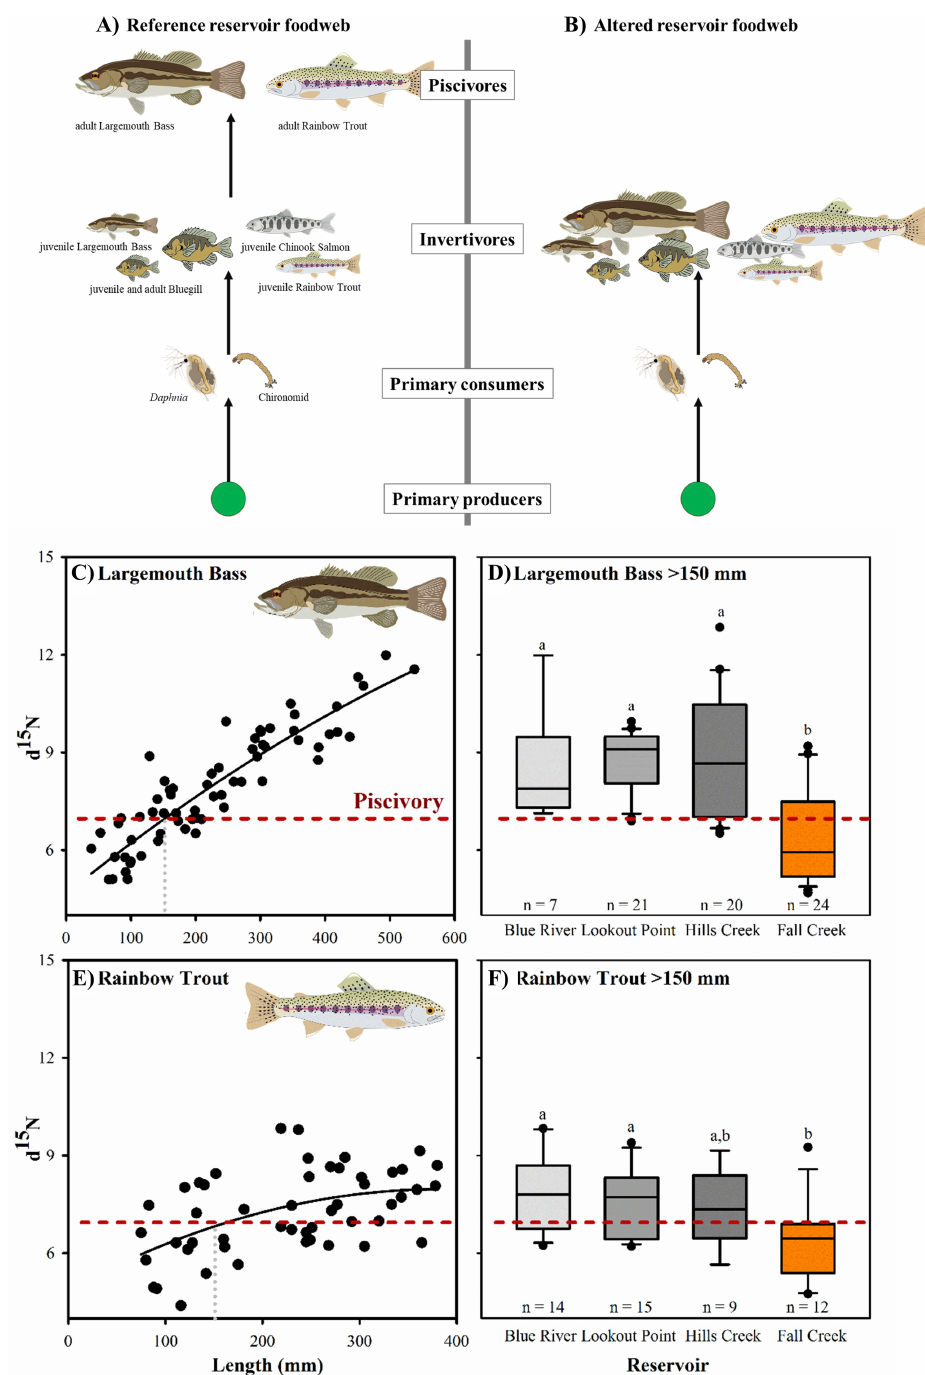
Fig 2. Trophic levels of key taxa (top) and δ 15 N ratios for Largemouth Bass and Rainbow Trout (bottom). (A) Reference reservoir food chain compared to the (B) altered reservoir food chain observed in the previously drained reservoir. Additional species found in Willamette Basin reservoirs but not pictured here include: bullhead catfish, Largescale Sucker and sculpin (detritivores); dace, mosquitofish, Redside Shiner, and Threespine Stickleback (invertivores); Bull Trout, crappie, Northern Pikeminnow, Walleye and Yellow Perch (juvenile invertivores, adult piscivores). (C and D) δ 15 N ratios increase naturally with increasing size of fish in reference reservoirs. The threshold for piscivory is indicated by a red dashed line. The grey dotted vertical line indicates the 150 mm threshold, above which fish diets are predominantly piscivorous. Although both species are capable of consuming fish as prey